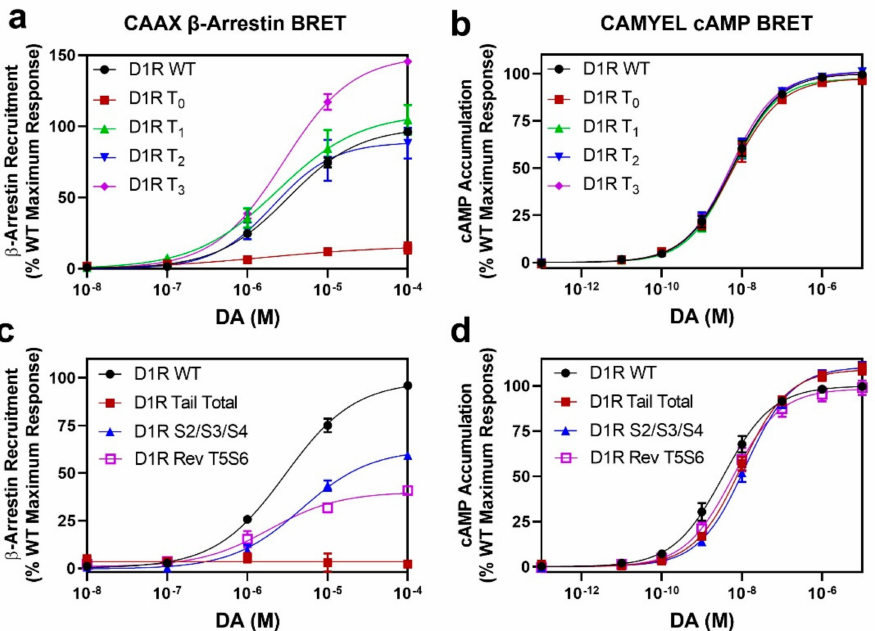
Figure 4. β -arrestin recruitment is impaired by specific D1R mutations while G protein signaling is unaffected. CAAX β -arrestin recruitment and CAMYEL cAMP accumulation assays were performed as described in Section 4. Data are expressed as a percentage of the maximum D1R WT DA response in each experiment and are displayed as the mean ± SEM of at least three experiments, performed in triplicate. Statistical comparisons between the following D1R WT and mutant curve parameters were made using a one-way ANOVA with Dunnett’s post hoc comparison: * p < 0.05, ** p <